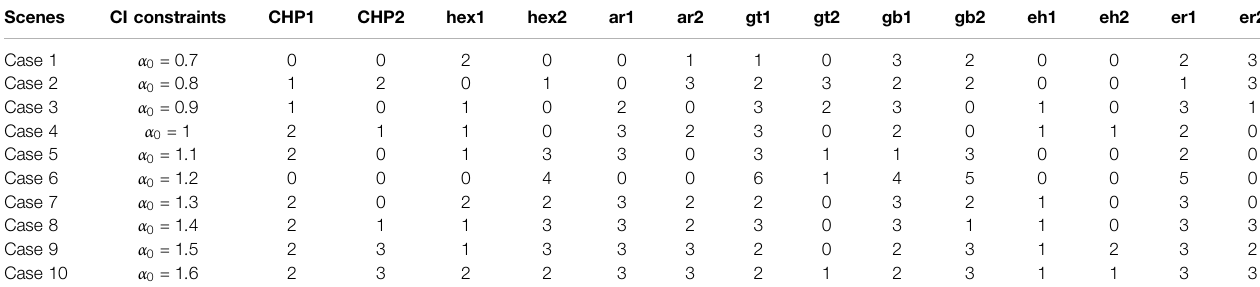
TABLE 7 | Planning results with different CIs. (a) Numbers of each energy conversion device. Scenes